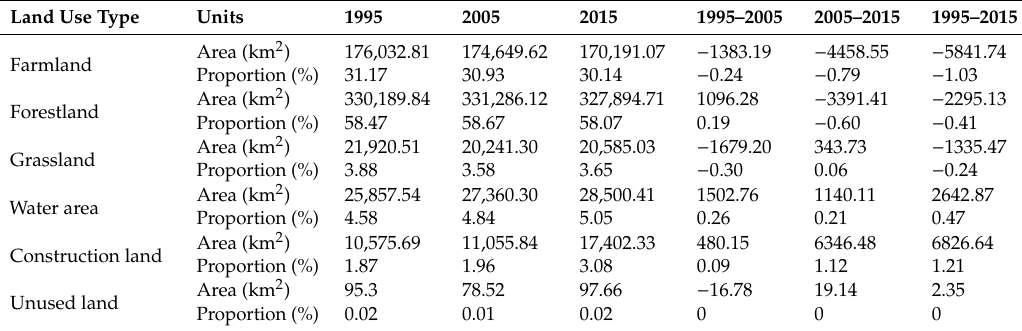
Table 1. Area and changes of land-use types in the Middle Reaches of the Yangtze River Urban Agglomerations (MRYRUA) from 1995 to